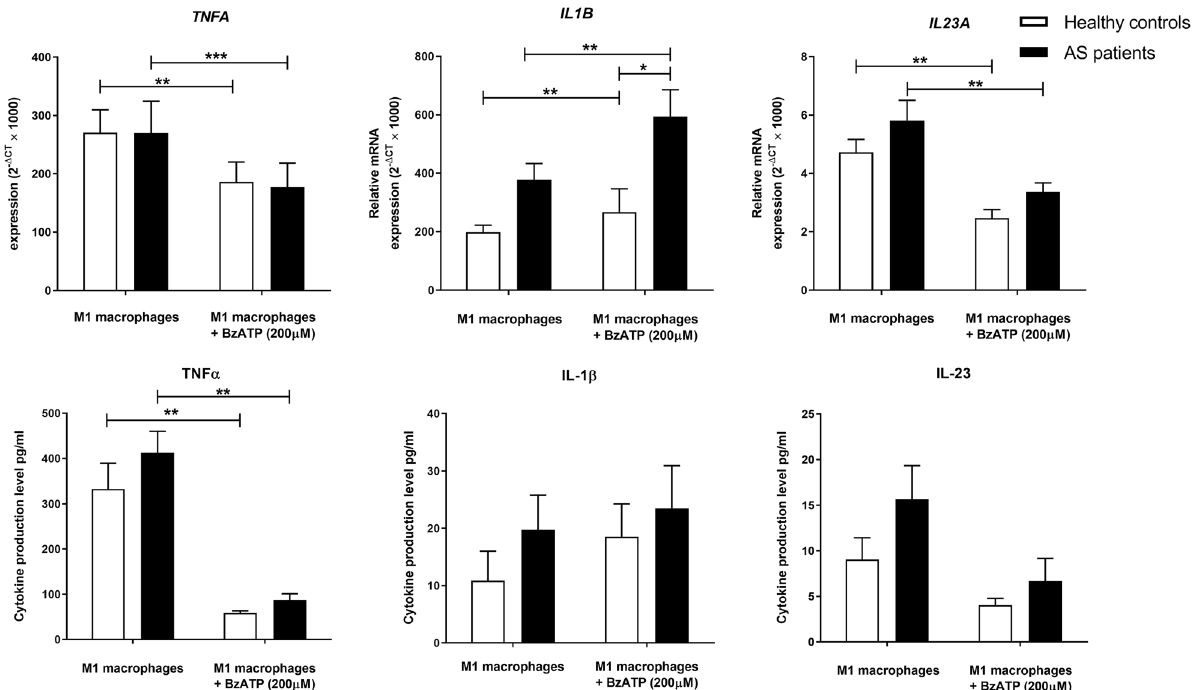
Figure 3. The effect of BzATP treatment on the production of pro-inflammatory cytokines in M1 macrophages from patients and controls. BzATP treatment significantly upregulated IL1B gene expression in M1 macrophages from both groups of macrophages. AS M1 macrophages significantly expressed higher IL1B mRNA in response to BzATP treatment compared to controls. Interestingly, BzATP significantly diminished the expression and production of TNF-α and the expression of IL23A in both healthy and AS M1 macrophages. The data are presented as the mean ± SEM (* P ≤ 0.05, ** P ≤ 0.01, *** P ≤